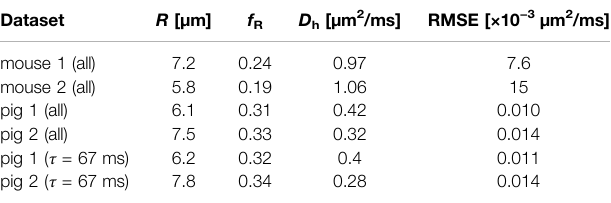
TABLE 2 | Summary of results from the global fi tting of the two compartment hindered-restricted model ( Eq. 17 ) toMD values from all encoding waveforms applied on preclinical (mouse) and clinical (pig) scanners. The estimated parameters are: cell radius R , restricted signal fraction f R , hindered diffusivity D h and the root mean square error (RMSE). For pig hearts, additional results are shown from a selected dataset only using long encoding times, τ = 67 ms.